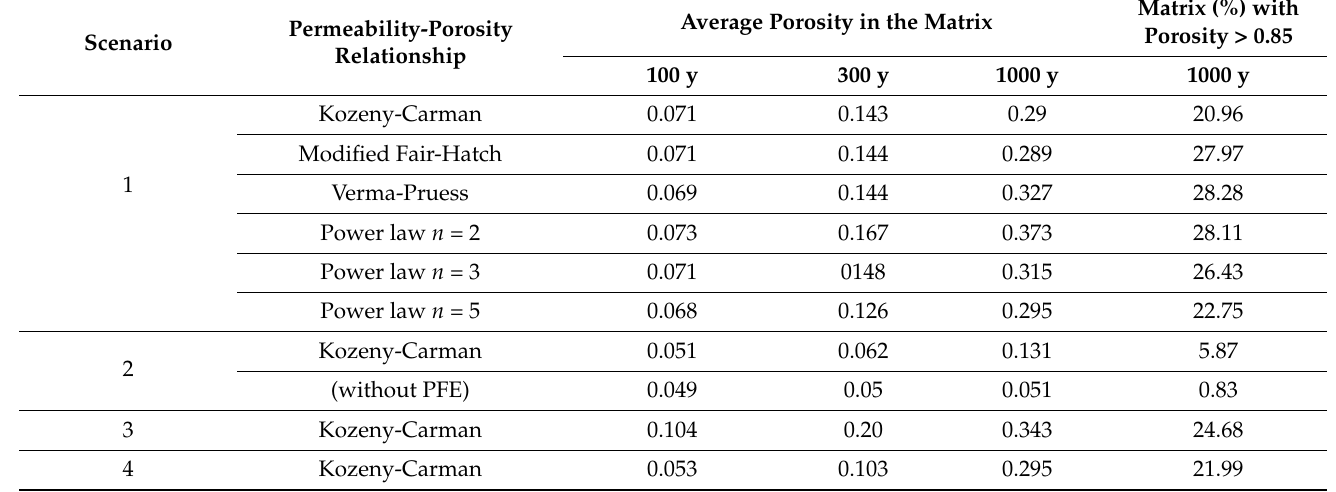
Table 5. Average porosity in the matrix after 100, 300, and 1000 years and the percentage of the matrix with porosity greater than 0.85 at the end of the simulations of scenarios 1 to 4 of the 2-D reactive transport model. PFE = porosity feedback